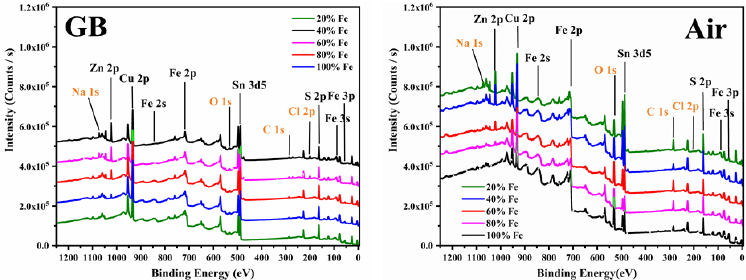
Figure 6. X-ray photoelectron spectroscopy, XPS, survey spectra of the 20%, 40%, 60%, 80%, and 100% C(Z,F)TS thin films, made in glovebox and in air.